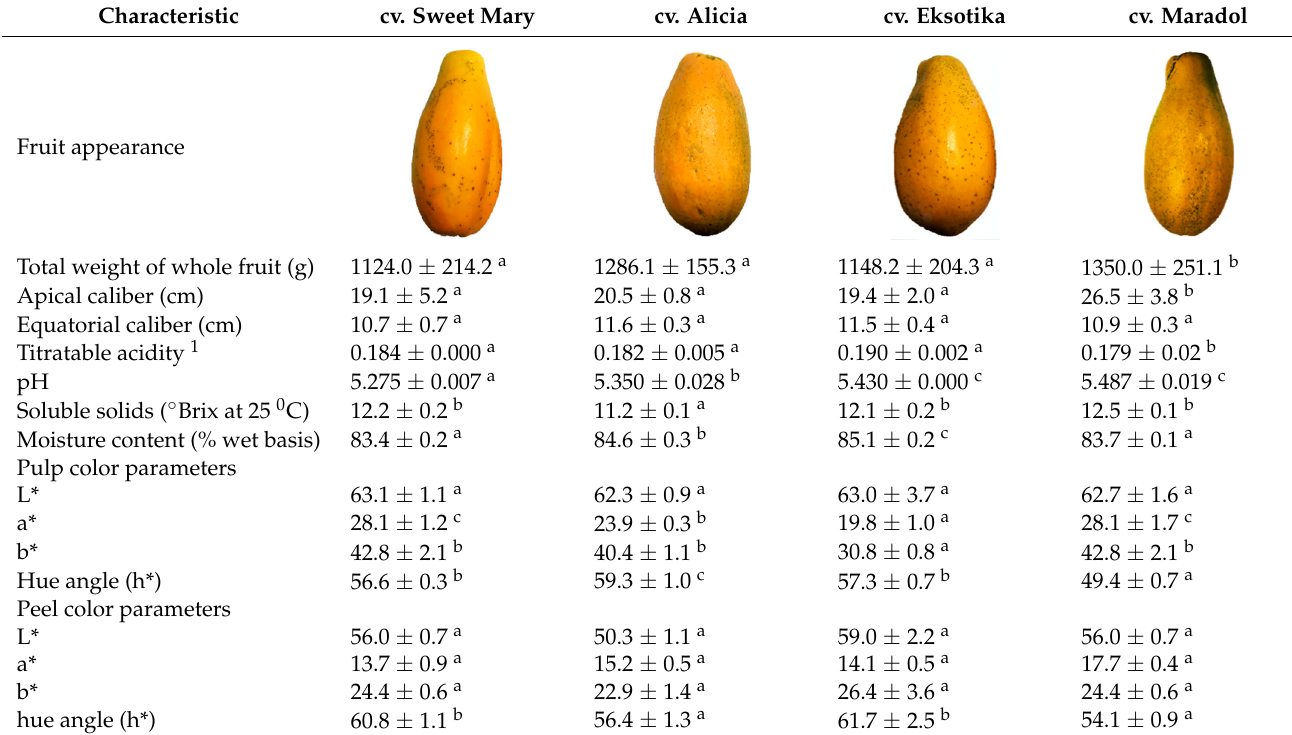
Table 1. Physical and physicochemical characteristics of papaya ( Carica papaya L.) Sweet Mary, Alicia, and Eksotika varieties from the Canary Islands (Spain) and cv. Maradol from Mexico. Characteristic